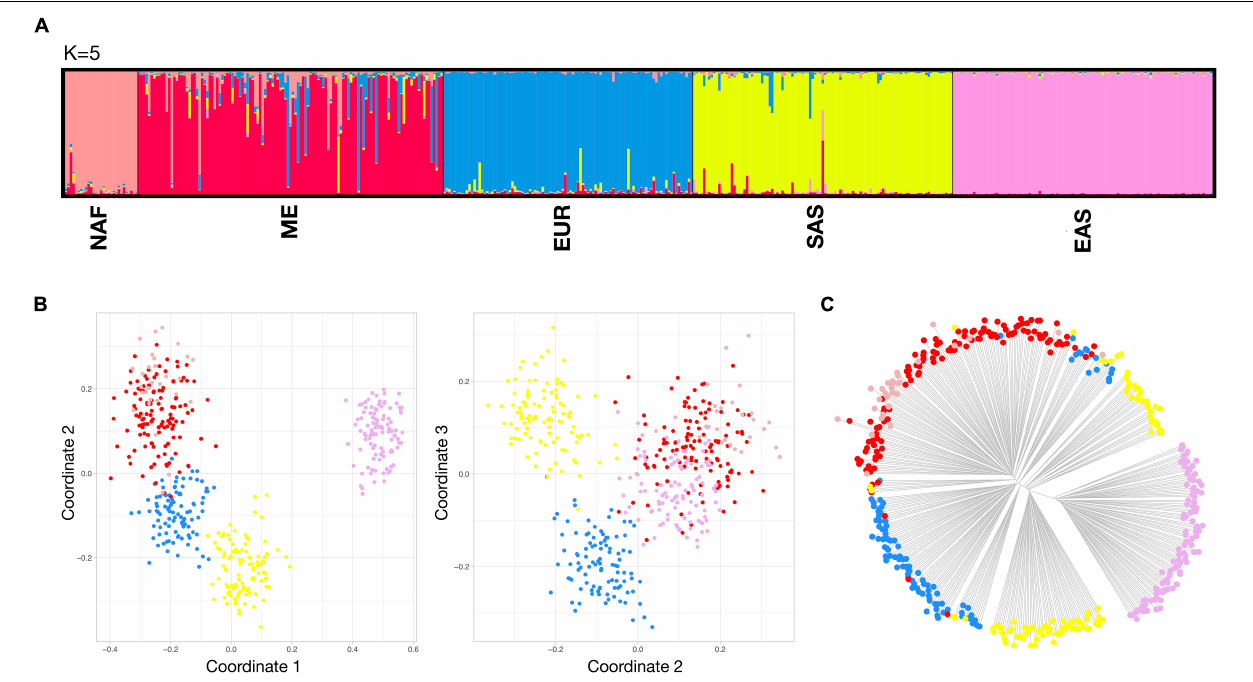
FIGURE 4 | Bio-geographical ancestry analysis of the five NAF-Eurasia reference population sets. (A) STRUCTURE results of ancestry proportions at K = 5. Each bar represents an individual and is colored in segments whose lengths correspond to their genetic cluster membership coefficients in up to five inferred population groups. (B) Three dimensional MDS analysis showing coordinates 1 and 2 (left) and 2 and 3 (right). (C) Neighbor Joining (NJ) tree analysis. For the MDS and NJ-tree, populations are colored according to the five different clusters which correspond to the five major populations identified in the STRUCTURE